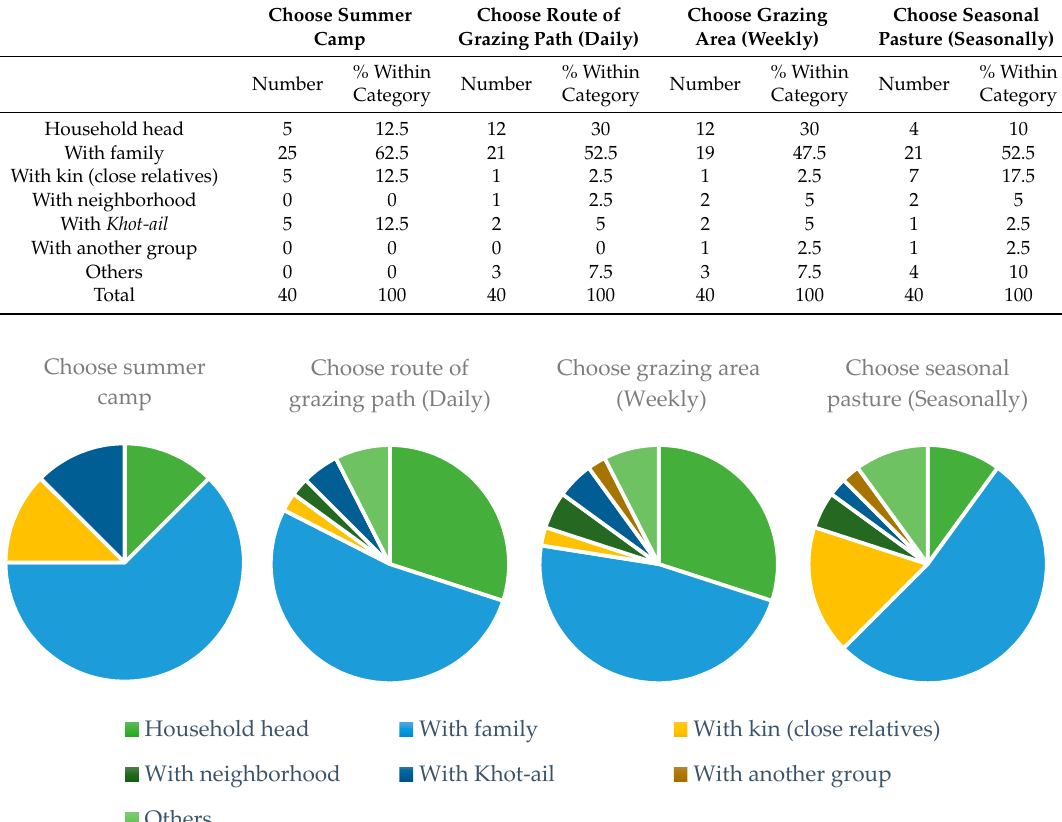
Figure 5. Adviser consulted when selecting the summer camp, grazing path, area, and pasture.